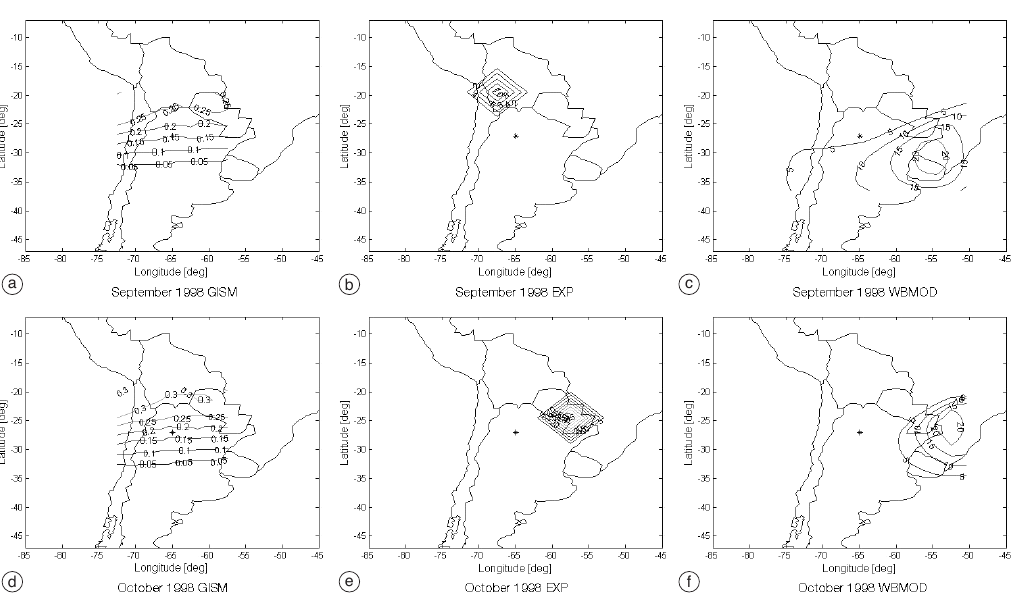
Fig. 5a-f. Percentages of occurrence of S 4 > 0.5 for experimental data and WBMOD and predicted S 4 values by GISM are shown at 20 LT during the day 15 of each month (September and October 1998).